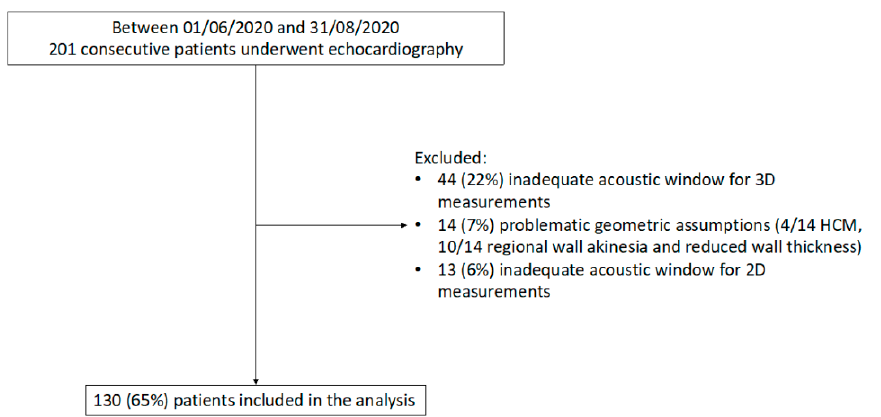
Figure 2. Flow diagram showing inclusion/exclusion criteria for the study population. HCM, Hypertrophic cardiomyopathy; 2D, two-dimensional, 3D, three-dimensional. Table 1. Baseline clinical characteristics of the study population.